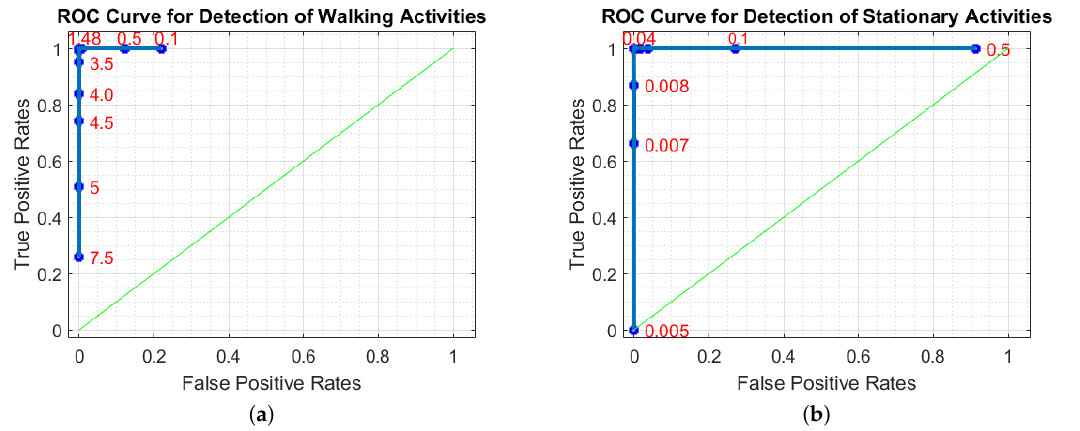
Figure 2. ROC of ( a ) walking activity detection by varying the values of Th W and ( b ) stationary activity detection by varying the values of Th